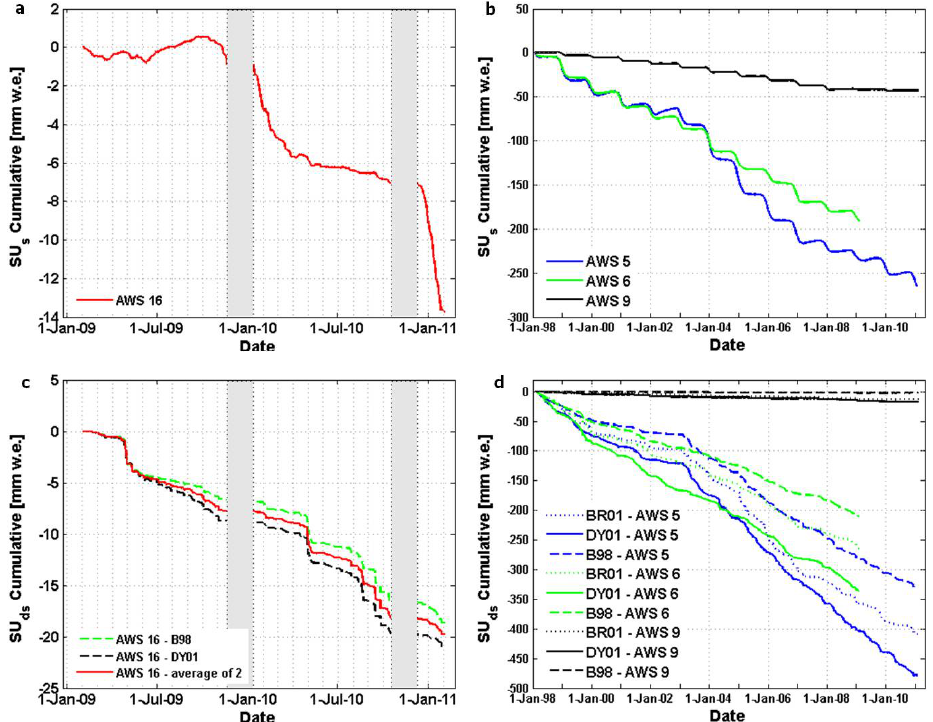
Fig. 3. Cumulative sublimation mass fluxes (mm w.e.): Surface sublimation SU s at (a) AWS 16 and (b) AWS 5, 6 and 9; Snowdrift sublima- tion SU ds at (c) AWS 16 and (d) AWS 5, 6 and